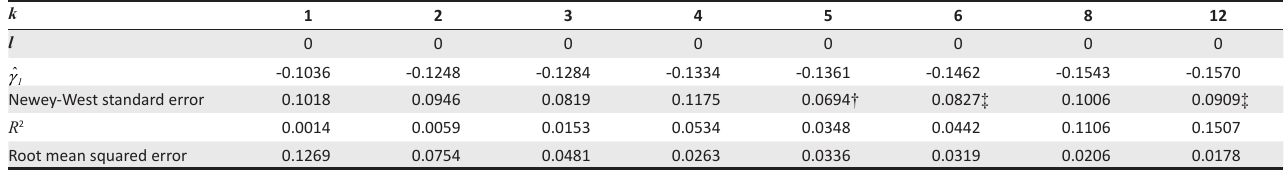
TABLE 2: Summary of results for the linear models of gross domestic product using the RYG